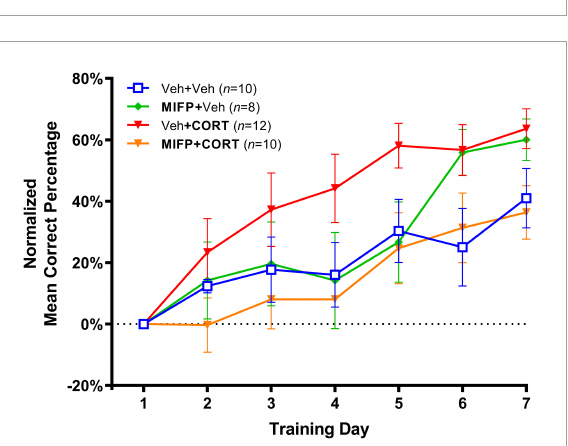
FIGURE3 Effect of CORT administration during adolescence on anxiety-like behavior in EPM adulthood. Time spent in the Closed, Center, and Open arms of the apparatus. CORT administration reduced the time spent in the open arms. ∗ p < 0.05.